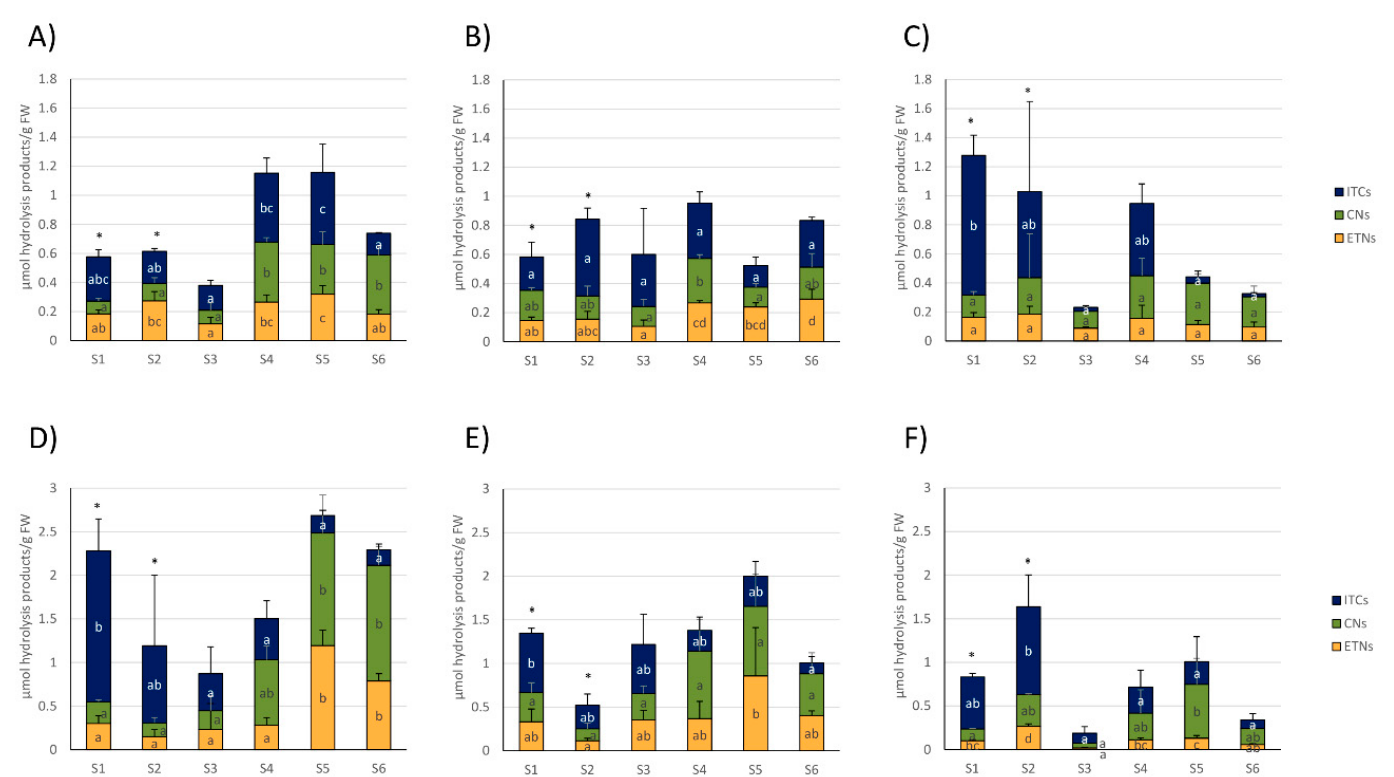
Figure 3. Formation of total isothiocyanates (ITCs), nitriles (CNs), and epithionitriles (ETNs) from white ( A – C ) and red cabbages ( D – F ) from conventional ( A , B , D , E ) and organic supermarkets ( C , F ) on di ff erent sampling dates (S1–S6). Exact sampling dates can be found in Table 1. ( A , D ) Represent conventional supermarket 1 (CON 1 ), ( B , E ) stand for conventional supermarket 2 (CON 2 ), and ( C , F ) show results from organic supermarket 1 (ORG 1 ). Each color in the bar of the given bar chart represents the mean minus standard deviation (SD) of the total ITC, CN, or ETN levels from three cabbage heads from the same supermarket ( n = 3). Di ff erent lower case letters indicate significant di ff erences in means between total ITCs, CNs, and ETNs levels in di ff erent samples, as tested by ANOVA and Tukey’s HSD test at the p ≤ 0.05 level. FW: Fresh weight. * Samples were analyzed from 1 g of sample homogenate (instead of 0.5 g).